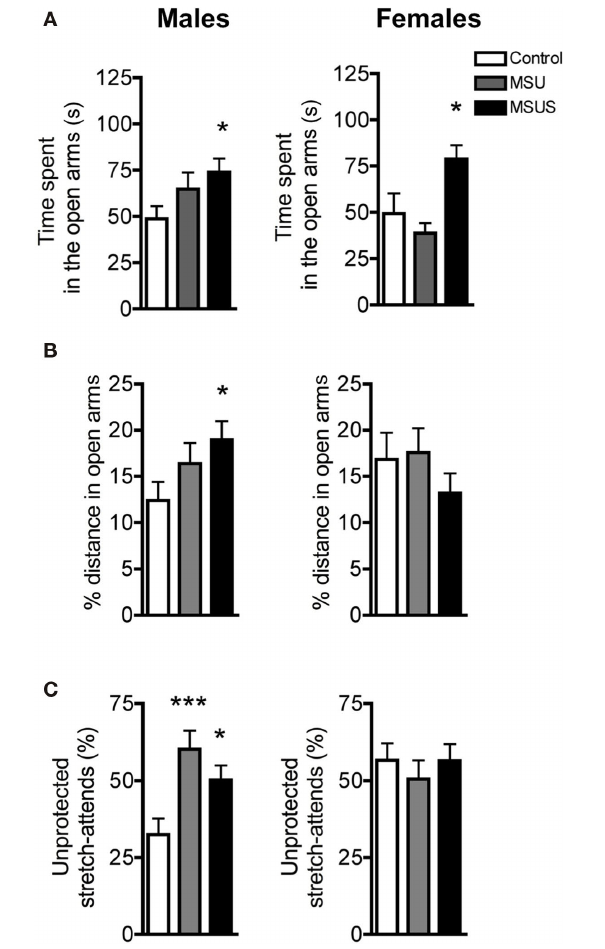
FigUrE 4 | F 1 control, MSU, and MSUS mice behavior in the elevated plus maze. (A) F 1 MSU and MSUS males demonstrated a graded increase in time spent in the open arms compared to control males (left). F 1 MSUS females spent significantly more time in the open arms than control and MSU mice (right). (B) F 1 MSUS males covered an increased proportion of their total distance in the open arm but there was no significant effect in F 1 MSU or MSUS females. (C) F 1 MSU and MSUS mice had an increased proportion of unprotected stretch attends (left). There was no effect in F 1 MSU or MSUS females (right). Males: MSU, n = 13, MSUS, n = 13, control, n = 16; females: MSU, n = 7, MSUS, n = 9, control, n = 7. *** p < 0.001; * p < 0.05. Bar graphs represent mean values ±